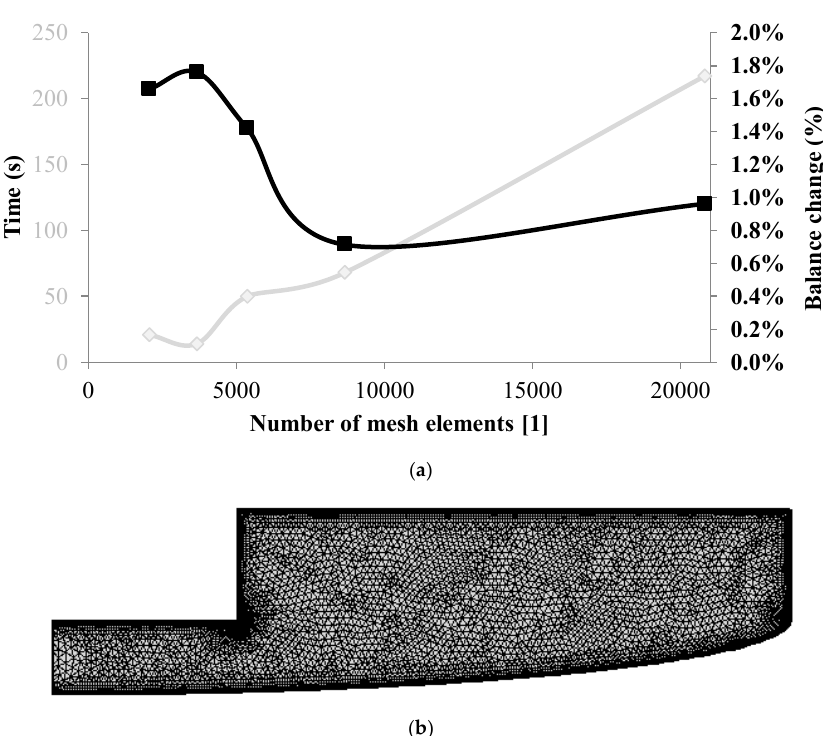
Figure 3. ( a ) the Results of the mesh independence study; ( b ) the applied mesh (8655 elements).